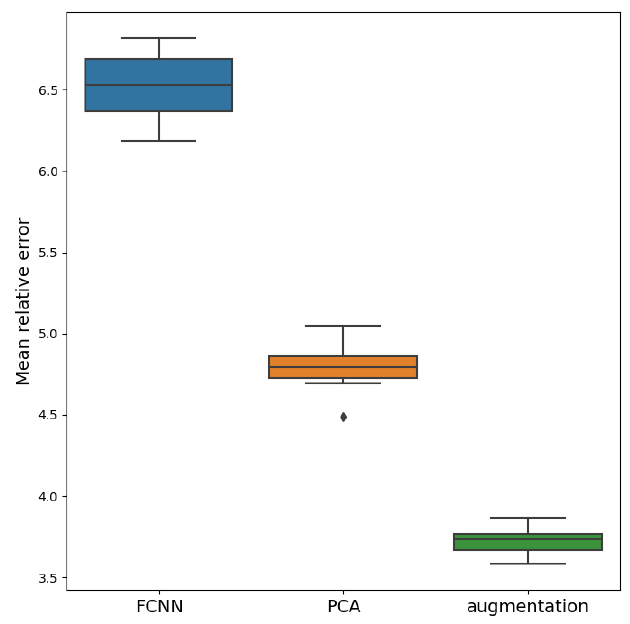
Figure 8. Distribution of mean relative percentage errors for 3 models trained on noisy